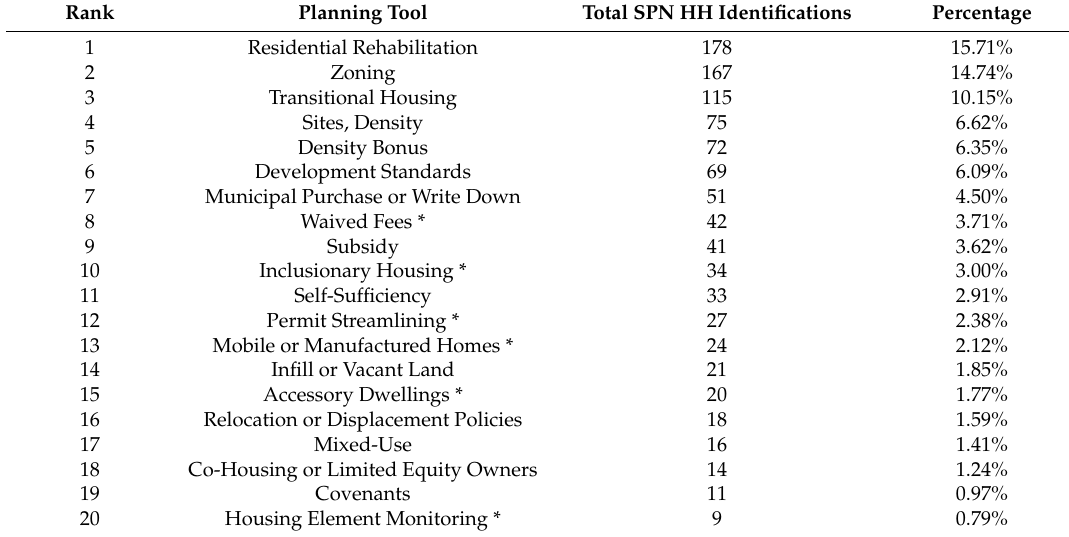
Table 6. The top twenty planning tools that accommodate low-income housing needs ranked by total SPN HH